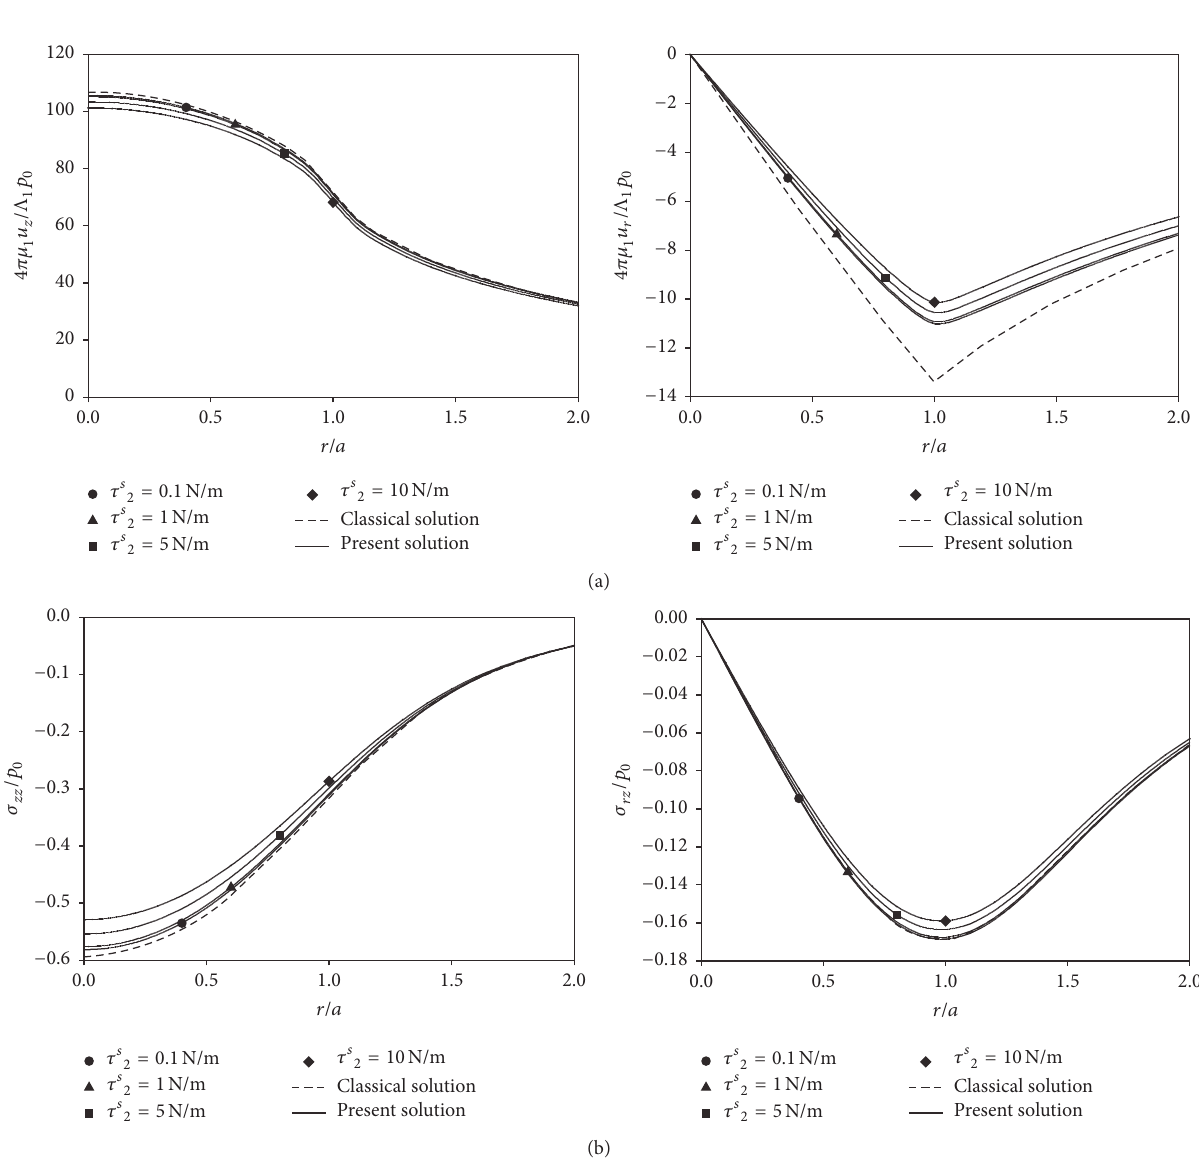
Figure 3: Radial variations of elastic fields under the vertical loading for ℎ/𝑎 = 1 and different magnitudes of residual surface stress (𝜏 𝑠 2 ) : (a) surface displacements (𝑧 = 0) and (b) stresses at the interface (𝑧 = ℎ)